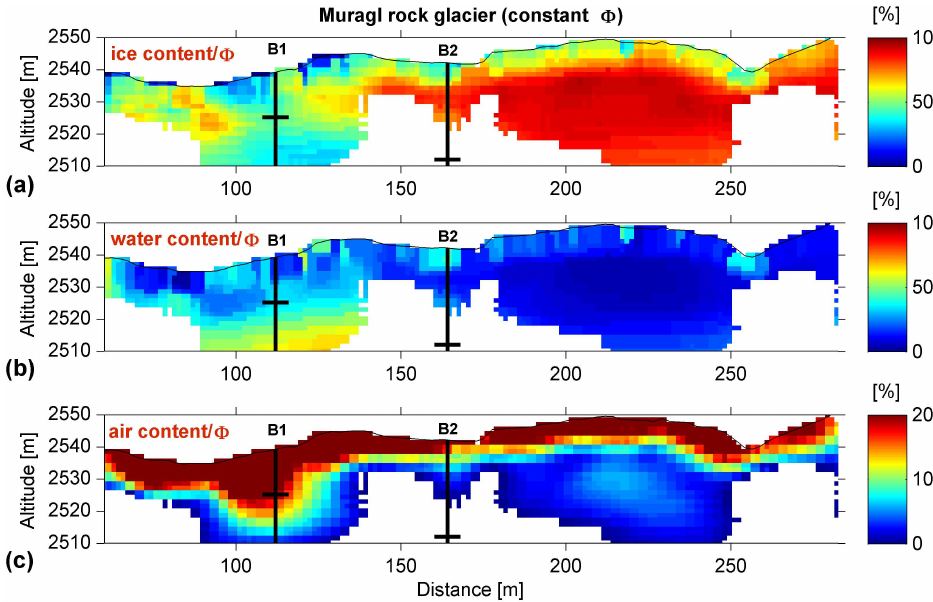
Fig. 8. As Fig. 7, but (a) , (b) and (c) are now calculated relative to the available pore space.